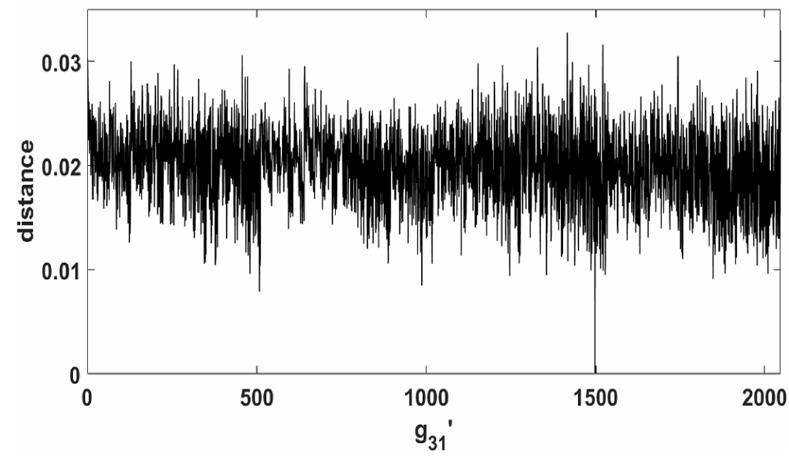
Figure 1. Harmonic Mean Distance (HMD) using two random variables A , B .